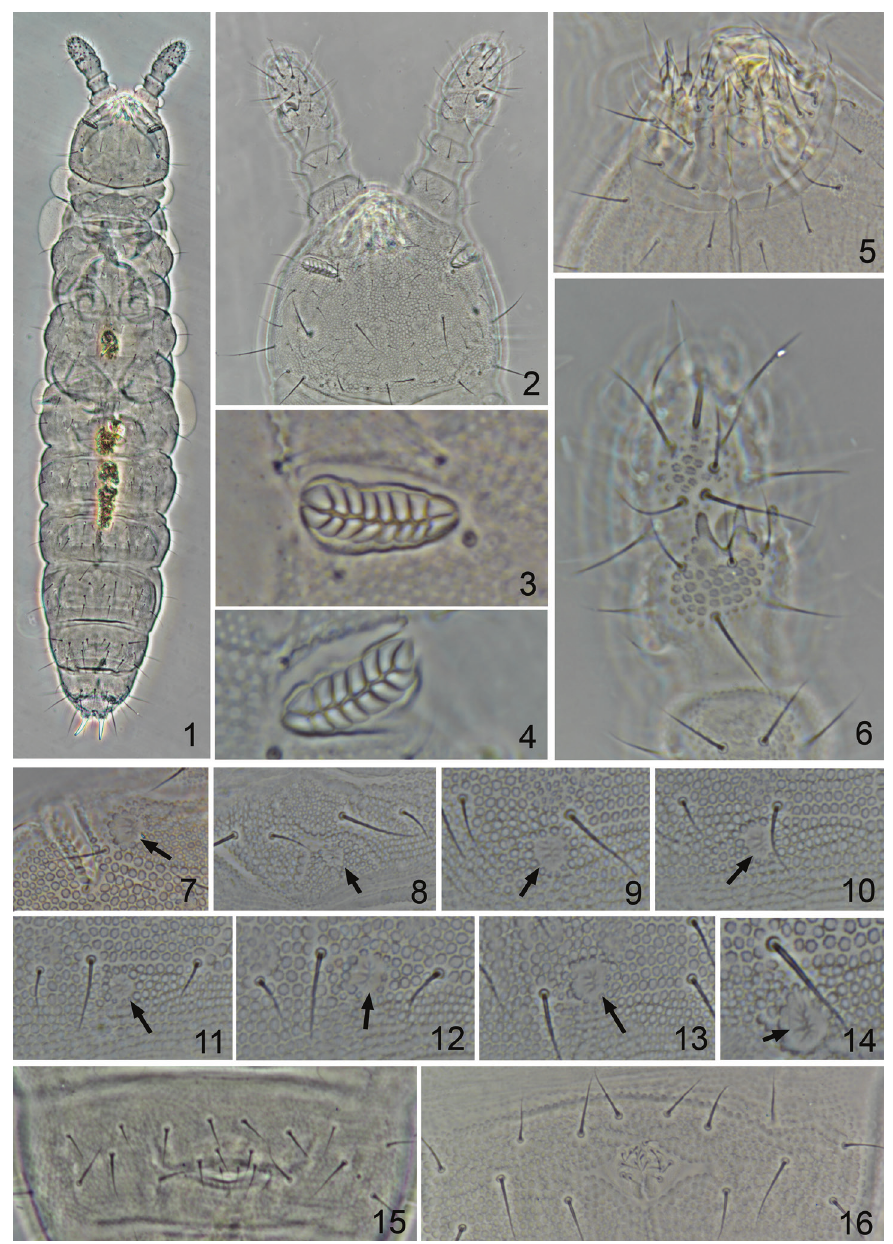
Left postantennal organ 4 Right postantennal organ (paratype XZ-C2015016) 5 Labium 6 Antenna, segments II–IV, dorsal view 7 Pseudocellus on anterior of head 8 Pseudocellus on Th. I 9 Pseudocellus on Th. II 10 Pseudocellus on Th. III 11 Pseudocellus on Abd. I 12 Pseudocellus on Abd. II 13 Pseudocellus on Abd. IV 14 Pseudocellus on Abd. V 15 Female genital plate 16 Male genital plate (paratype XZ- C2015021). Arrows in figs 7–14 indicate the